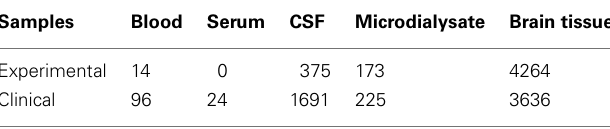
Table 2 | Comparing biosamples collected for the various analyses in clinical and in experimentalTBI